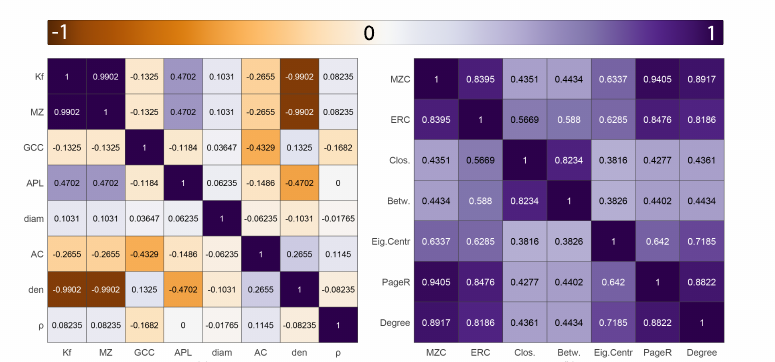
Figure 9. ( a ) The correlation between the global graph measures for more than 10 3 graphs generated by the Watts − Strogatz small − world model with | V | ∈ [ 1500,2500 ] , m 0 = 50 and p = 0.15. ( b ) The correlation between the local measures of each vertex of the graph generated by the Watts − Strogatz small − world model with | V | = 2500, m 0 = 50 and p =